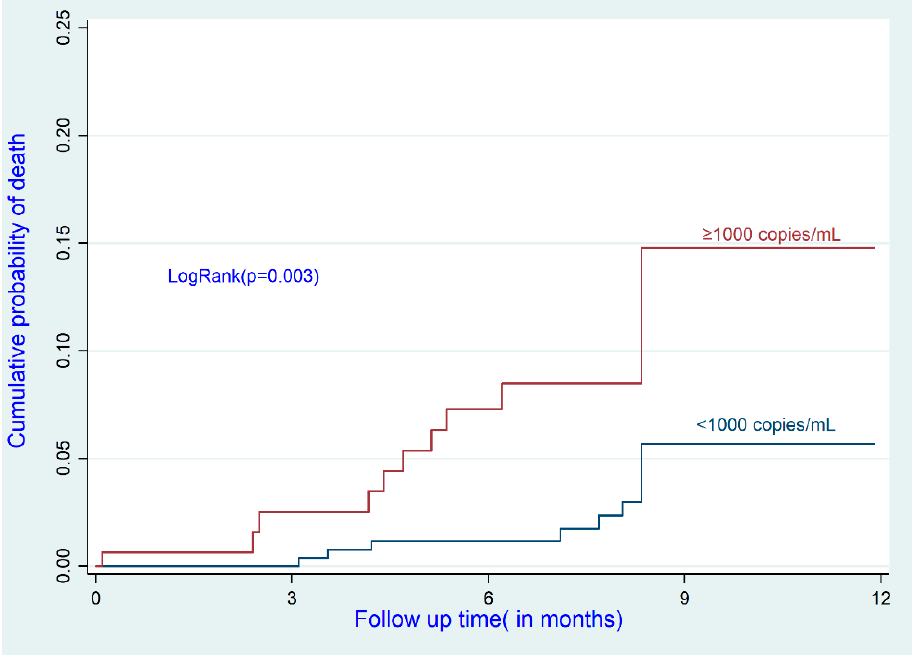
Figure 3. Cumulative incidence of death by viral load at baseline. Table 3. Multivariate analysis of predictors of mortality ( n = 468).